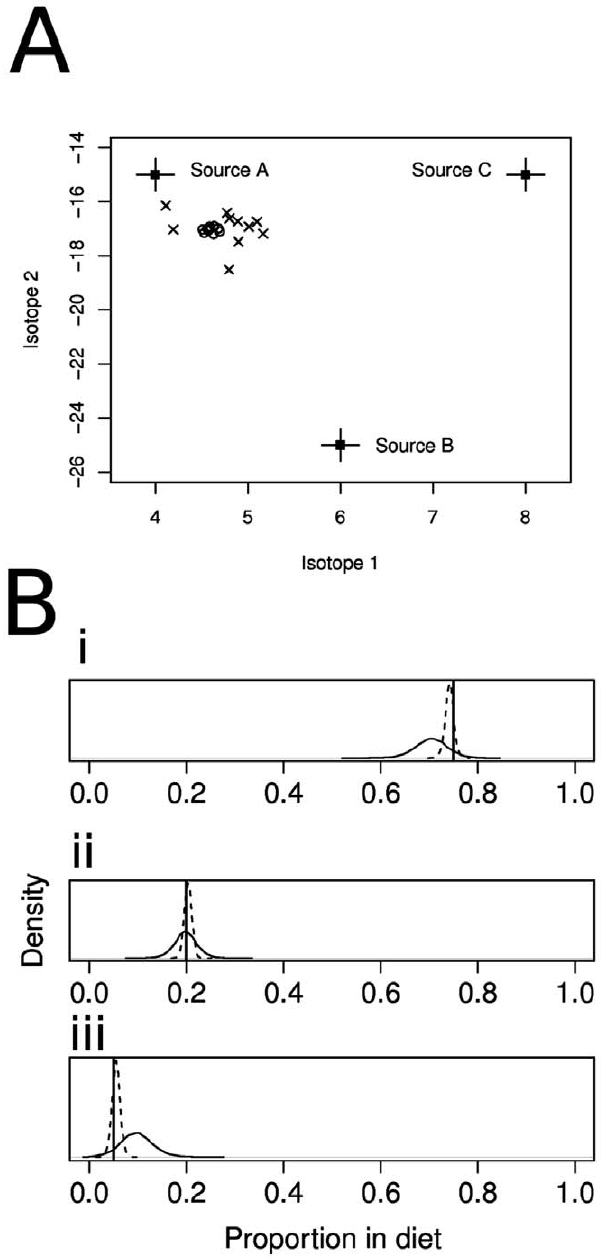
Figure 1. Two example simulated datasets and corresponding model performance on estimating the underlying parameters. (A) Consumer (open circles and crosses) and source (filled squares) isotope values from two data sets with different between-individual variability in the animal isotope measurements (standard deviation s =0.1 for open circles, compared with 0.5 for crosses). (B) Posterior density estimates of the proportions for both models. The true values of the proportions are shown in the vertical lines. In both cases, the true proportions are inside the 95% credibility intervals of the posterior